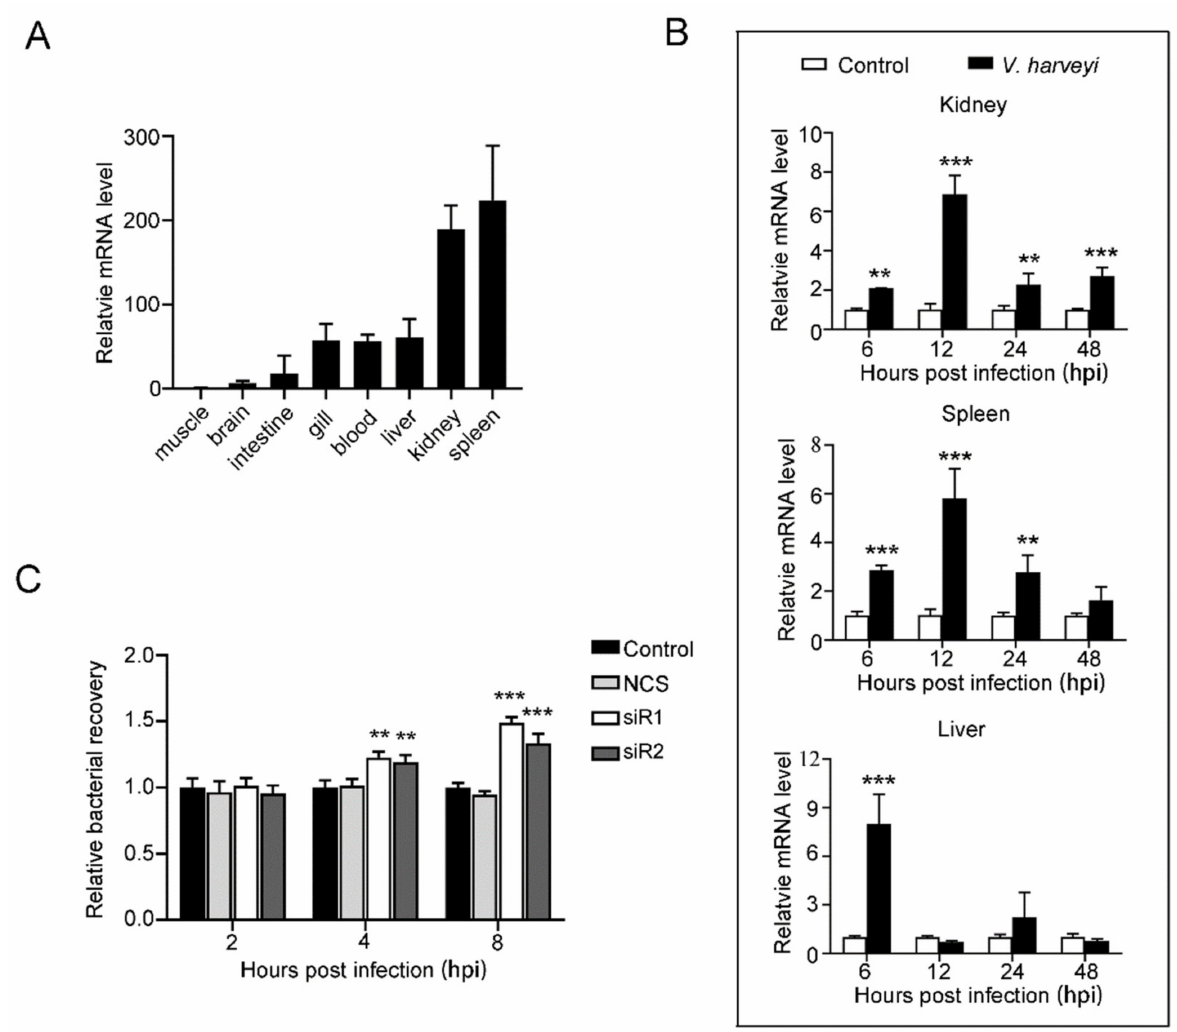
Figure 2. NKLnc expression and its effect on bacterial infection. ( A ) NKLnc expression in flounder tissues under normal physiological conditions was determined by RT-qPCR. The expression levels are presented relative to that in the muscle. ( B ) Flounder were infected with or without (control) Vibrio harveyi for different numbers of hours, and the expression of NKLnc in the kidney, spleen, and liver was determined by RT-qPCR. ( C ) FG-9307 cells were treated with or without (control) NKLnc-targeting siRNA (siR1 or siR2) or the negative control siRNA (NCS) and then infected with V. harveyi for different numbers of hours. The bacterial recovery was determined. For panels ( B , C ), values are the means of replicate experiments and shown as means ± S.D. *** p < 0.001; ** p <